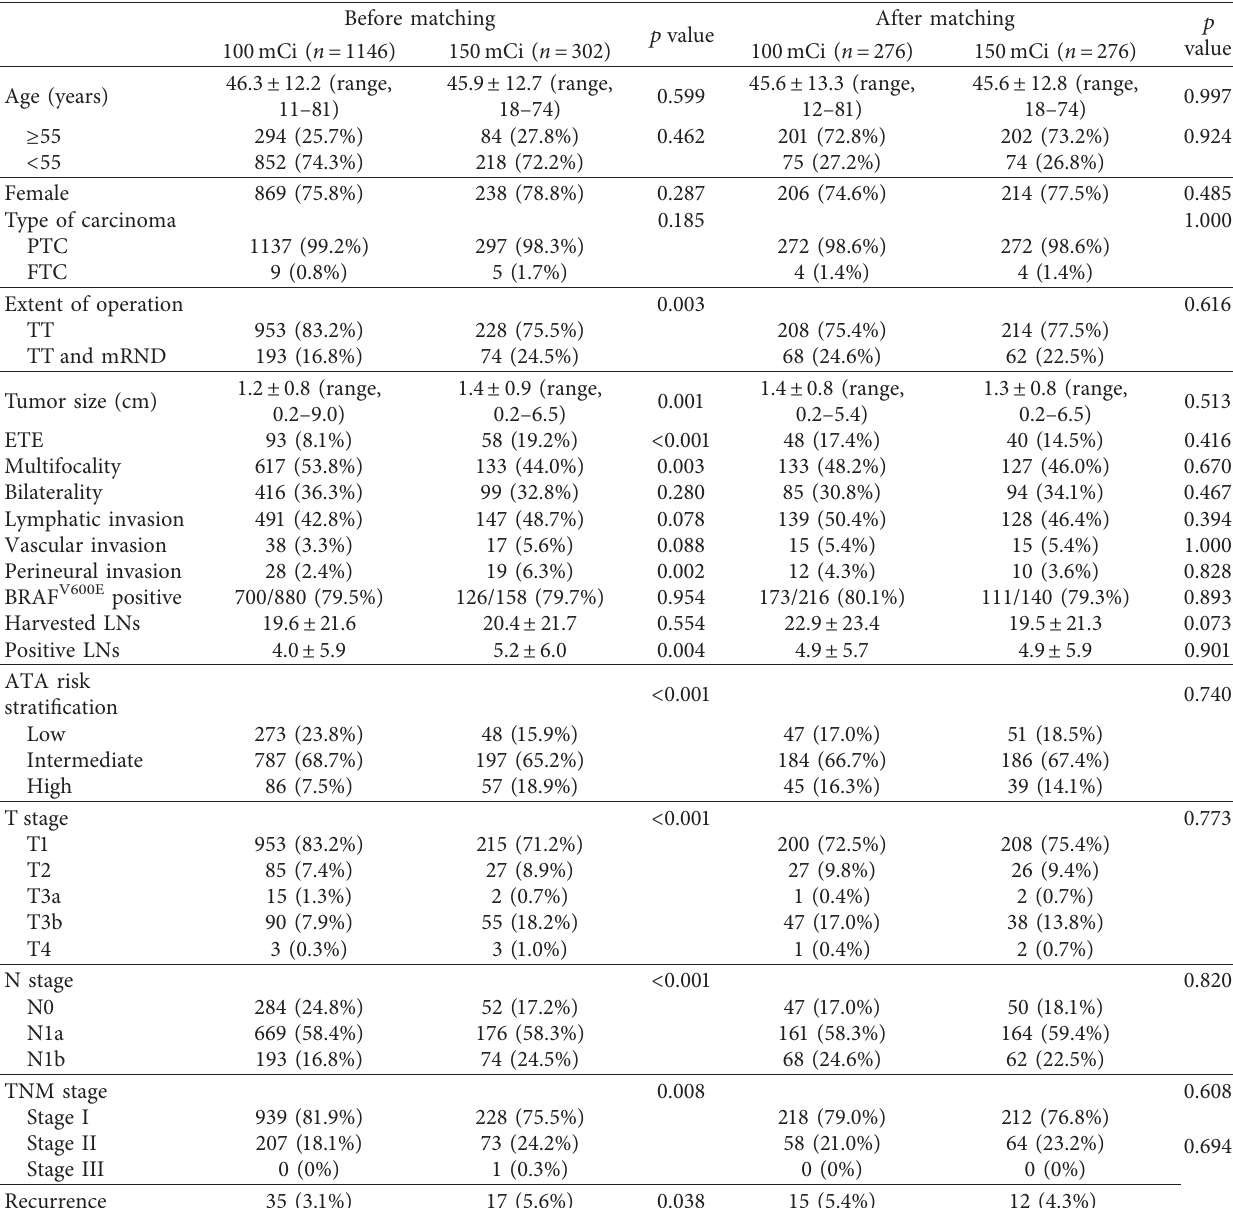
Table 1: Comparison of baseline clinicopathological characteristics between intermediate- (100mCi) and high-dose (150mCi) groups before and after propensity score